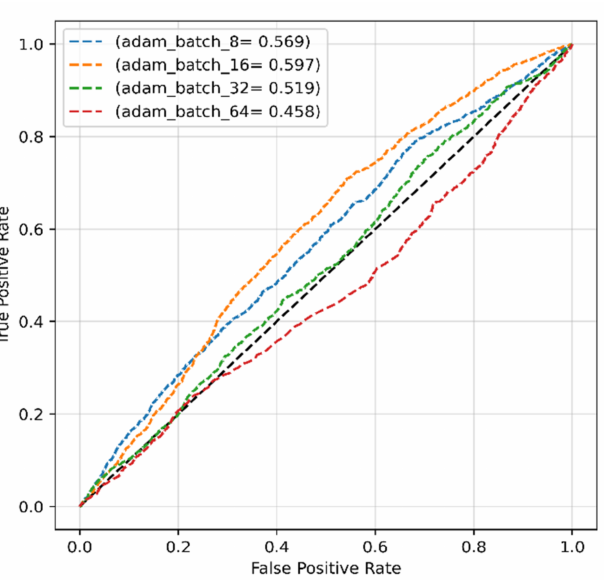
Figure 13. The ROC of the proposed model obtained with modified dataset and ADAM optimizer.